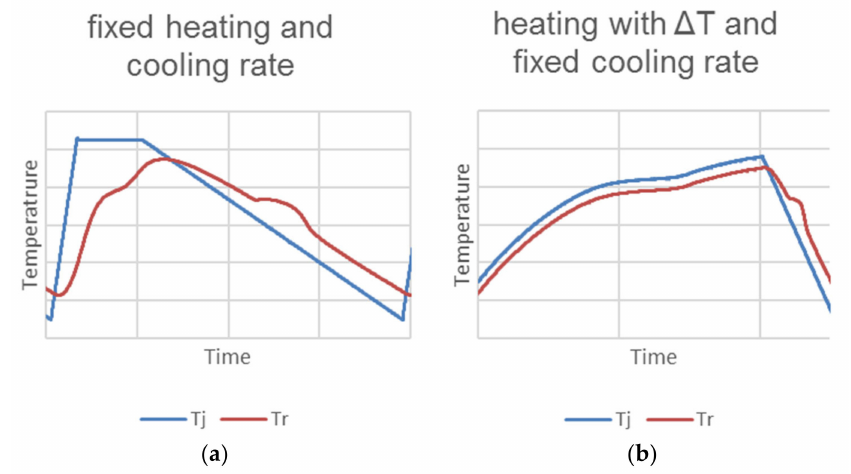
Figure 8. Typical temperature profiles of the stability testing device “HSLU” (fixed heating and cooling rate ( a ), constant temperature di ff erence upon heating and fixed cooling rate ( b )); jacket temperature T j , and reaction temperature T r